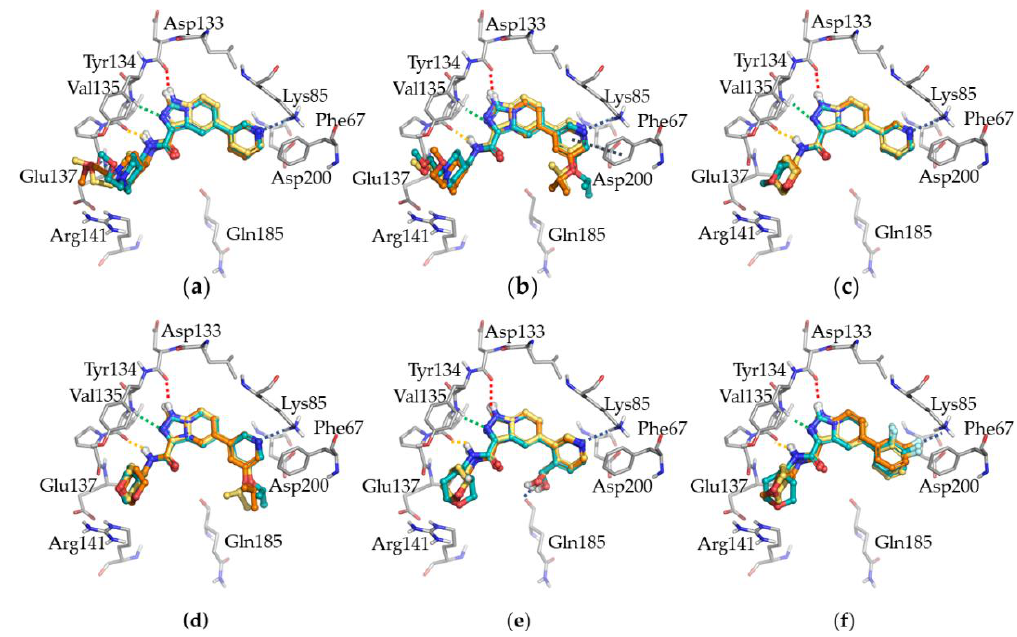
Figure 3. Binding poses of INDZ, IMID 1, and IMID 2 derivatives, reported as yellow, cyan, and orange ball and sticks representation, respectively, in complex with GSK-3 β . Each panel represents a triad bearing the same R 1 and R 2 groups, ( a ) 1 - 7 - 13 , ( b ) 2 - 8 - 14 , ( c ) 3 - 9 - 15 , ( d ) 4 - 10 - 16 , ( e ) 5 - 11 - 17 , ( f ) 6 - 12 - 18 . The most relevant residues of the ATP binding site are also showed in grey. Deep, central, and outer H-bonds are represented in red, green, and orange, respectively, while dark dashed lines refer to other interactions involving Phe67, Lys85, and Gln185. Table 2. Glide SP docking score of the selected poses of derivatives 1 – 18 . RMSD of the